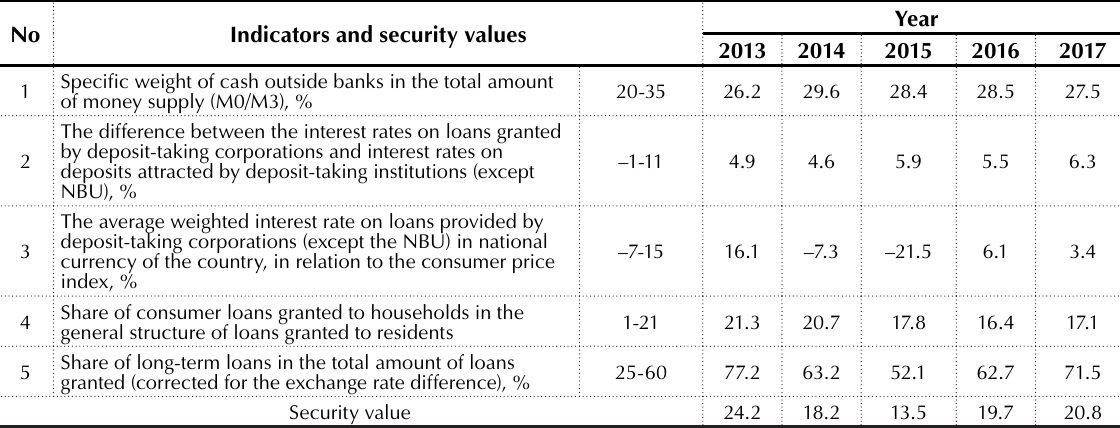
Table 3. Indicators of monetary security of Ukraine in the period 2013–2017 No